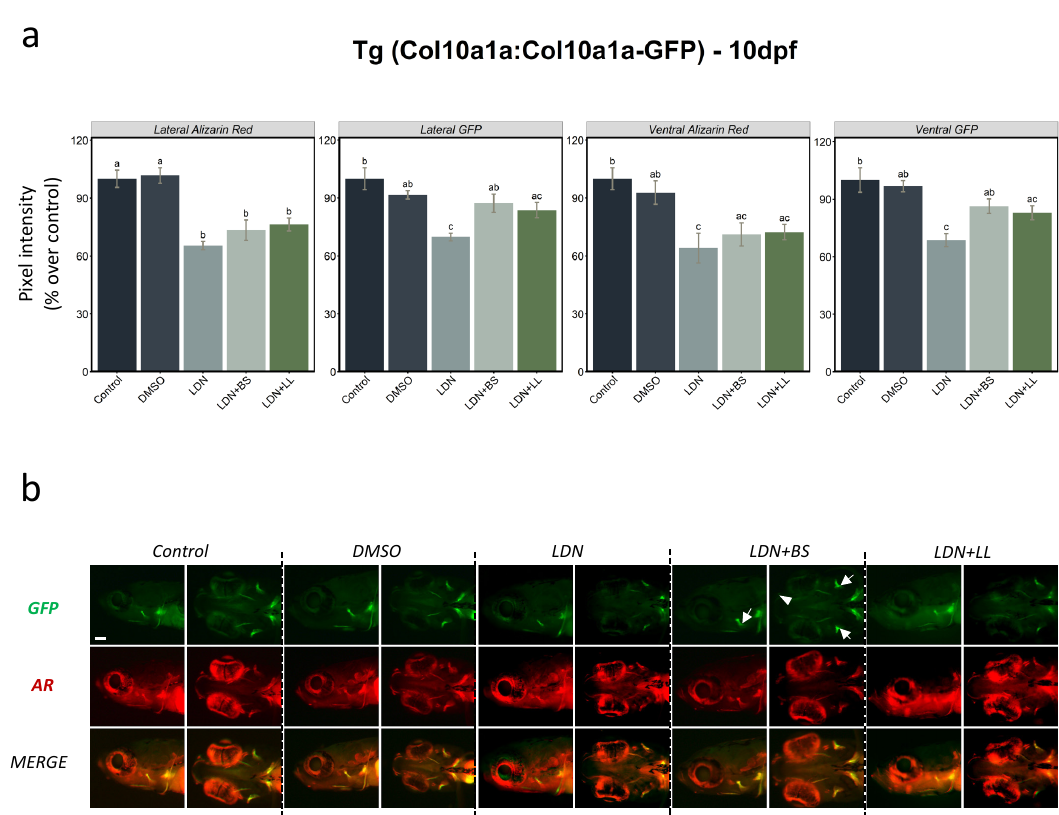
Figure 6. BMP inhibitor exposure followed by two probiotics treatments in Tg(col10a1a:col10a1a- GFP ) larvae. ( a ) Integrated pixel intensity values for various areas measured in 10 dpf zebrafish Tg(col10a1a:col10a1a-GFP) larvae divided into various groups—control, DMSO, LDN, LDN+BS and LDN+LL—and stained with AR. DMSO was used as additional control since it was employed as the solvent for LDN. One-way ANOVA and Tukey’s multiple comparison tests were used, and statistical significance was set at p < 0.05. Different letters denote statistically significant differences among the experimental groups. ( b ) GFP, AR staining and merged images of the head area (lateral and ventral views) of Tg(col10a1a:col10a1a-GFP) larvae of the different treated groups. White arrows denote GFP in various bony structures and the white arrowhead indicates the presence of a signal in additional structures (that was absent in other groups) in BS-treated fish after LDN exposure (LDN + BS).